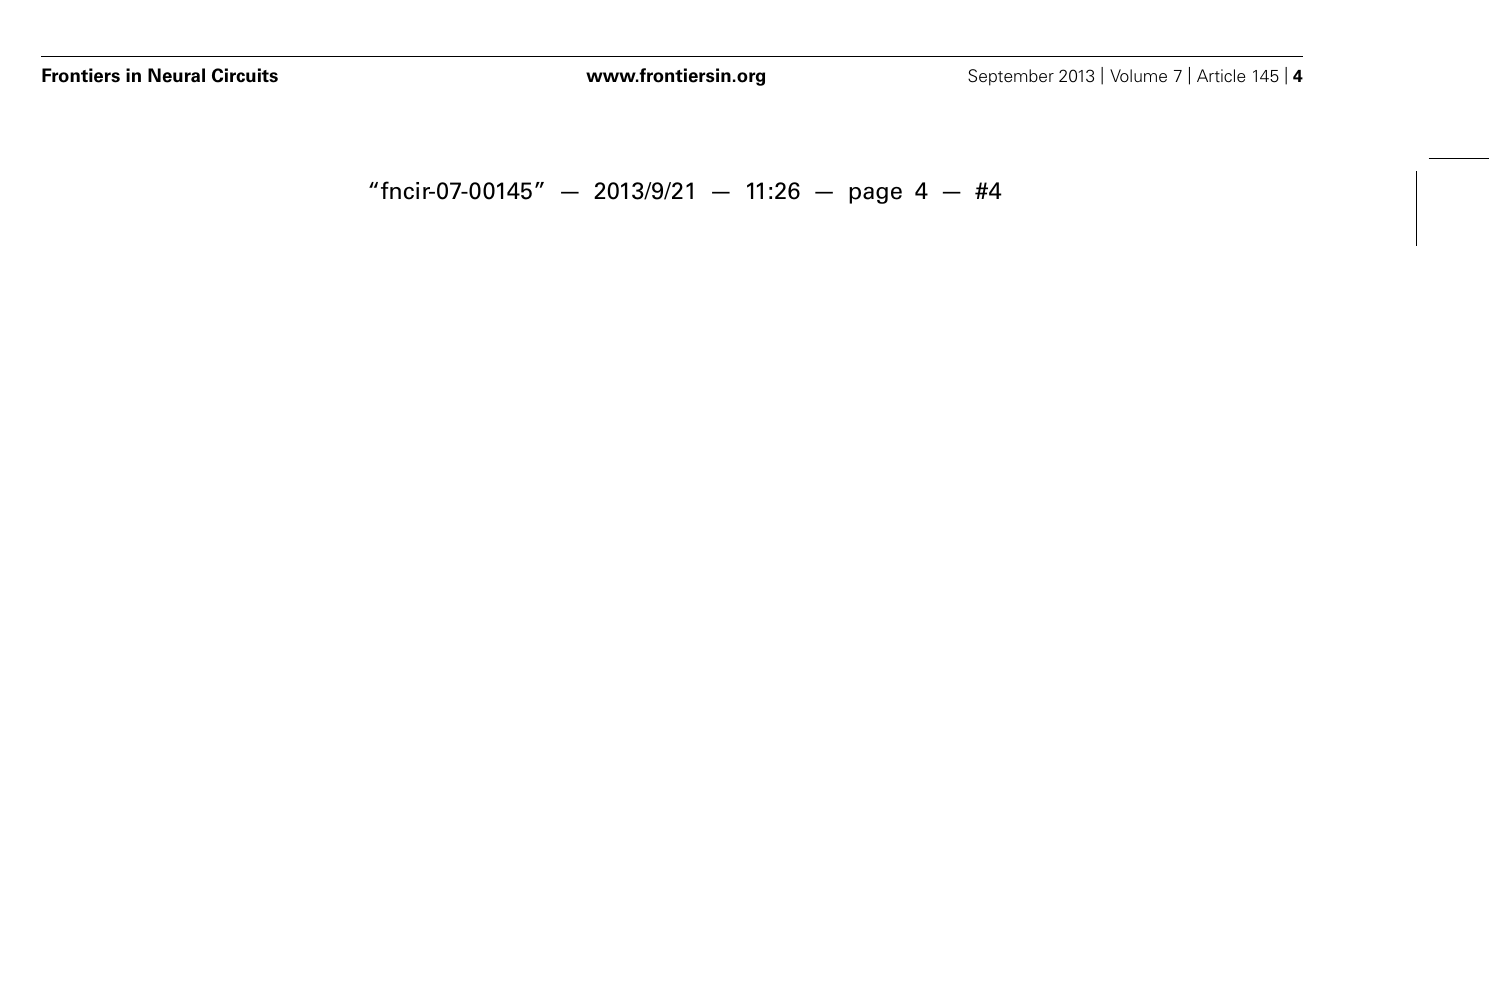
signals generated by flashes delivered 60, 150, and 420 s after background onset. The dashed line indicates the delay in the onset of recovery in the mutant. (G) Reduction of a -wave amplitudes in dark-adapted gr s357 mutants. In these experiments, the b -waves were pharmacologically suppressed by bathing the fish in L-APB (1 mM, pH 7) for 60 min before recording. Peak photocurrents were reduced in the mutant ( n = 9) at light intensities greater than log unit = − 4.7. Threshold (at log unit = − 5.64) of the photoresponse was not affected. Sibling larvae ( n = 14; 9 heterozygotes and 5 homozygous WT) did not show significant differences over the light intensities tested. Bars: SEM. Light intensity was 81 mW/cm 2 at log unit =